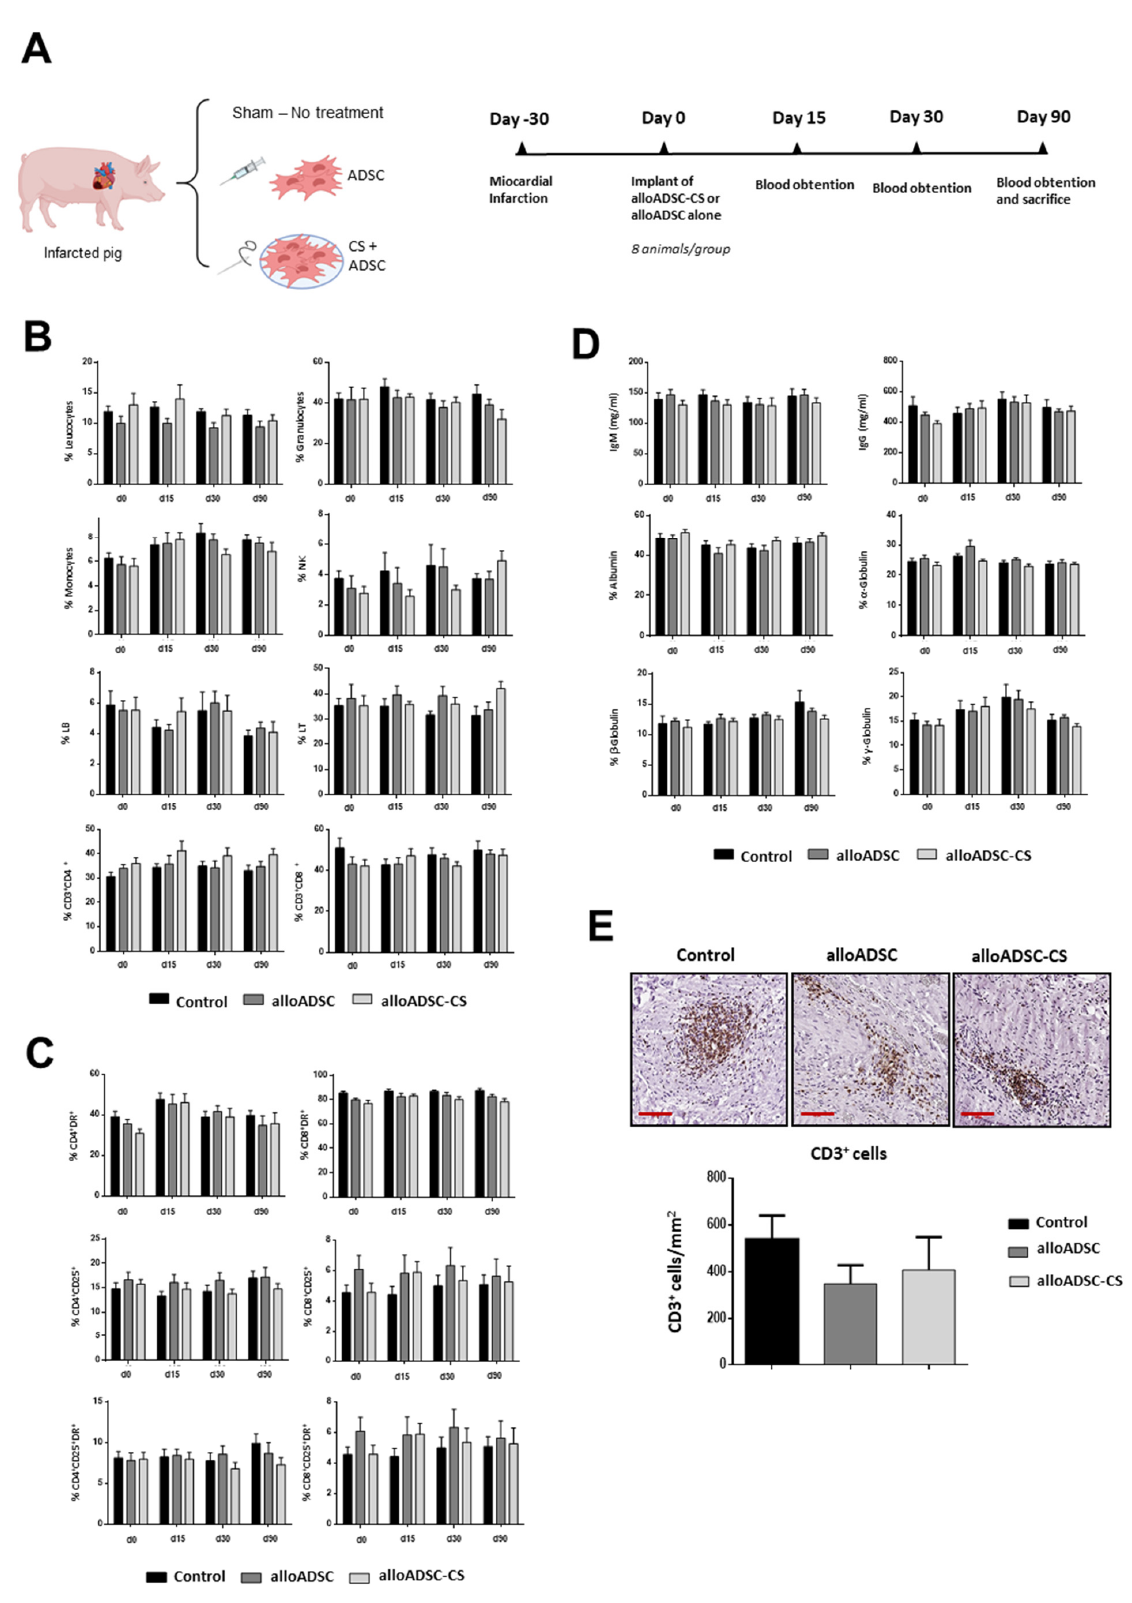
Figure 2. Immunological analysis in a preclinical porcine model of MI epicardially implanted with pig alloADSC-CS. ( A ) Experimental design. Adult pigs were implanted with only pig alloADSCs or alloADSCs seeded onto CS 1-month post-